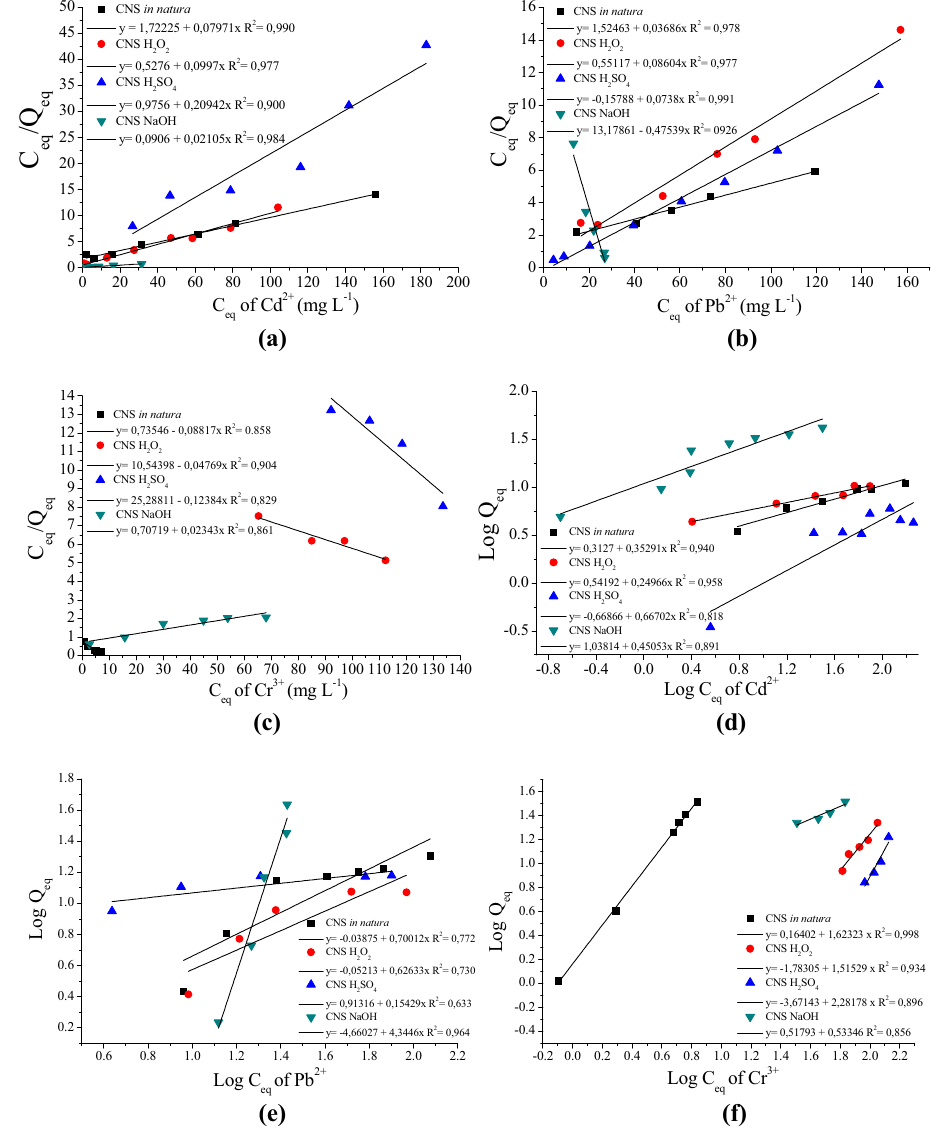
Fig. 12 Linearization of the mathematical models of adsorbent materials: CNS in natura (Coelho et al. 2014) and modified with H and NaOH by Langmuir for Cd 2+ ( a ), Pb 2+ ( b ), Cr 3+ ( c ) and Freundlich for Cd 2+ ( d ), Pb 2+ ( e ) and Cr 3+ ( f